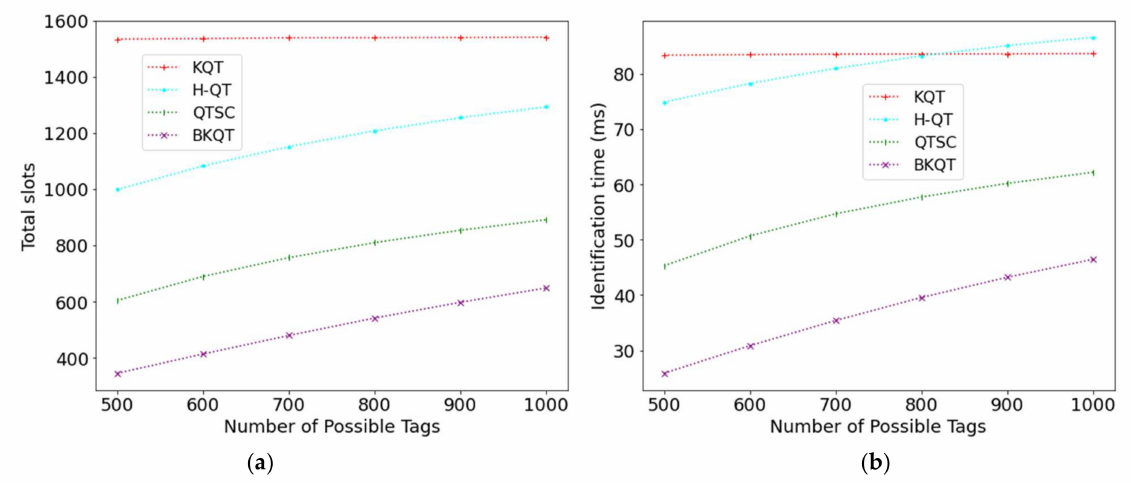
Figure 4. Total slots and identification time subject to the number of possible tags. ( a ) Total slots, ( b ) Identification